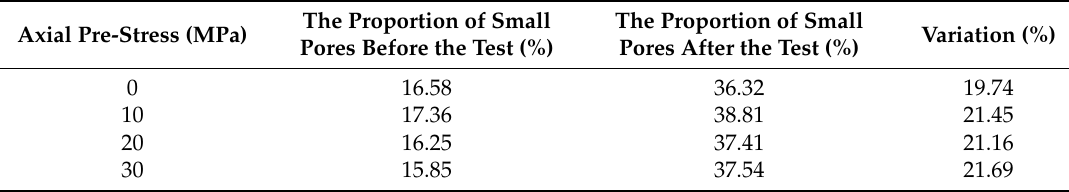
Table 4. The proportion of large pores before and after the